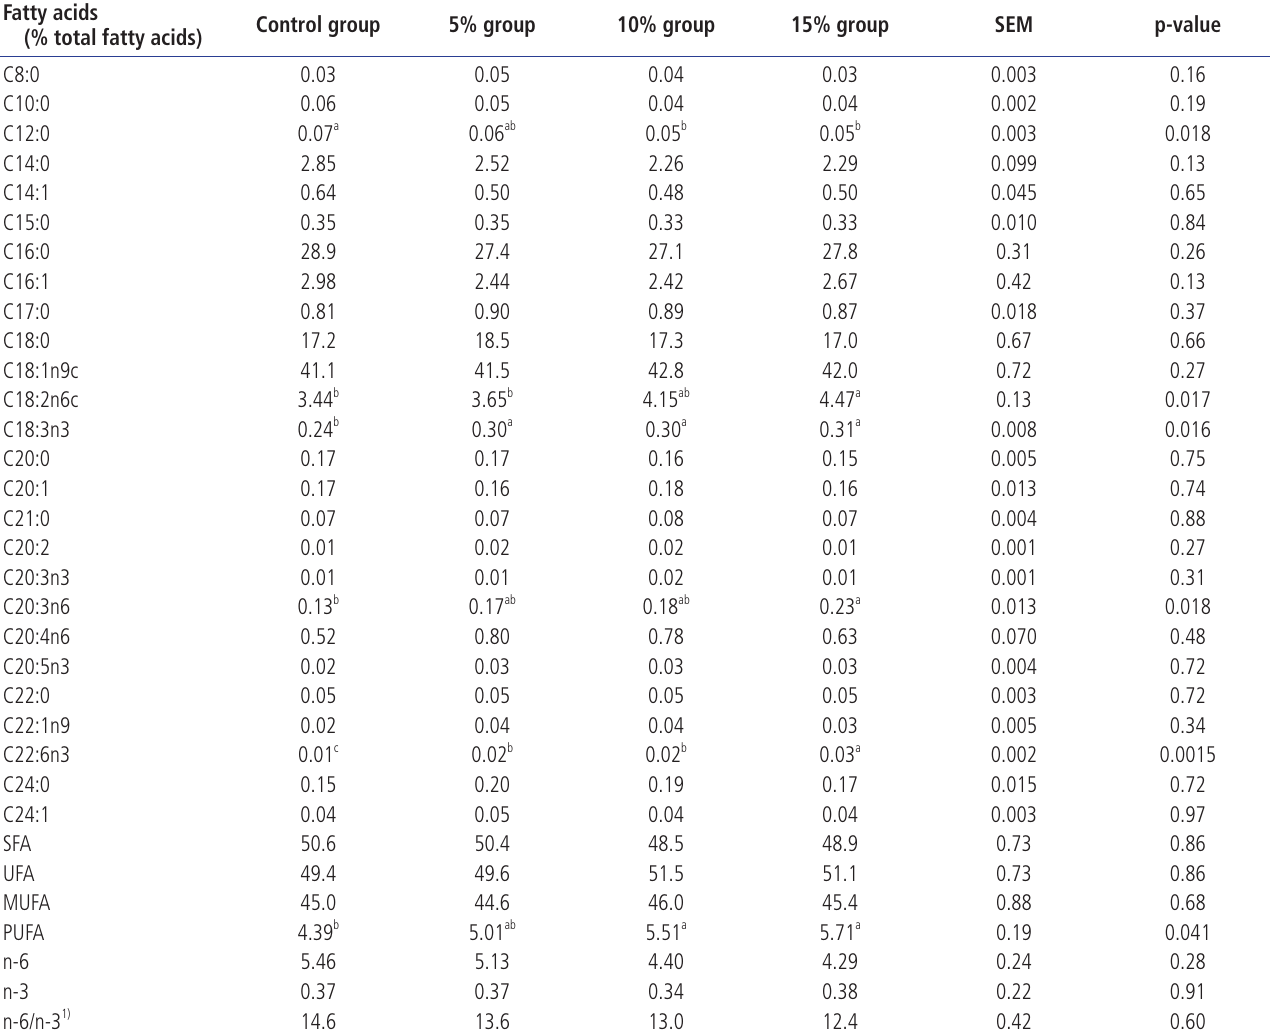
Table 7. Effect of Broussonetia papyrifera silage levels on fatty acids composition in meat of black Angus Fatty acids Control (% total fatty acids)